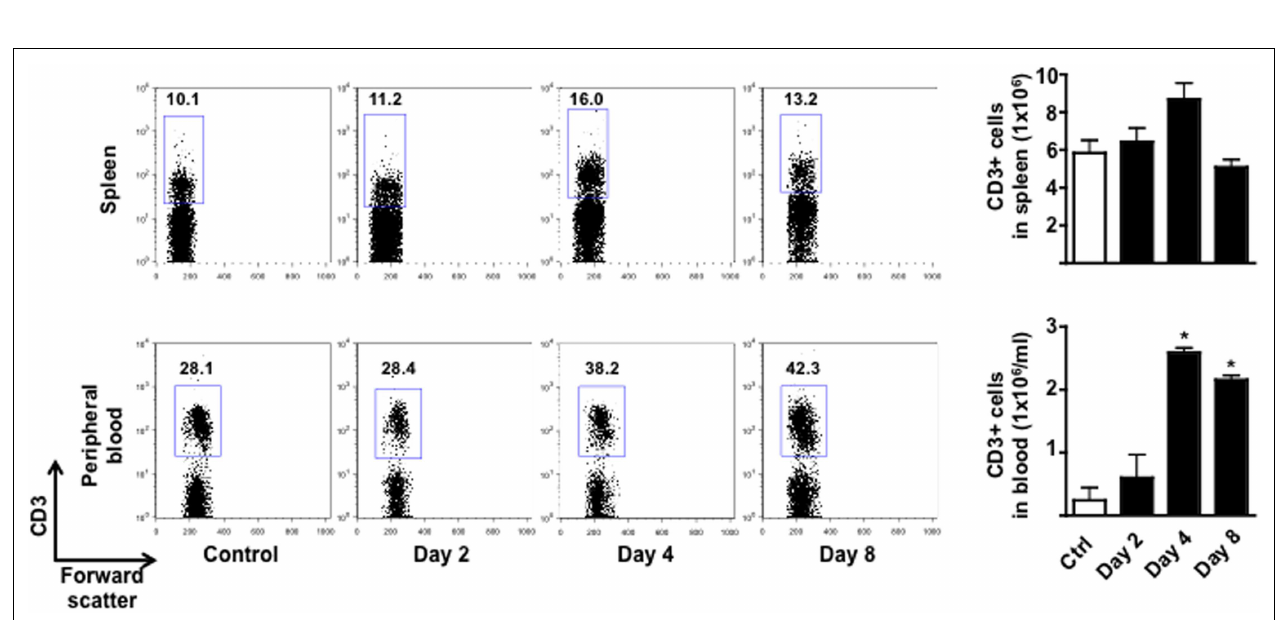
FIGURE 2 | Behavior of MOG 35–55 -immunized mice in the open field test .The graphs show the total number of squares crossed (A) , number of central squares entries (B) , latency to rearing, and the relative linear regression (C,D) of control or MOG 35–55 -immunized mice assessed